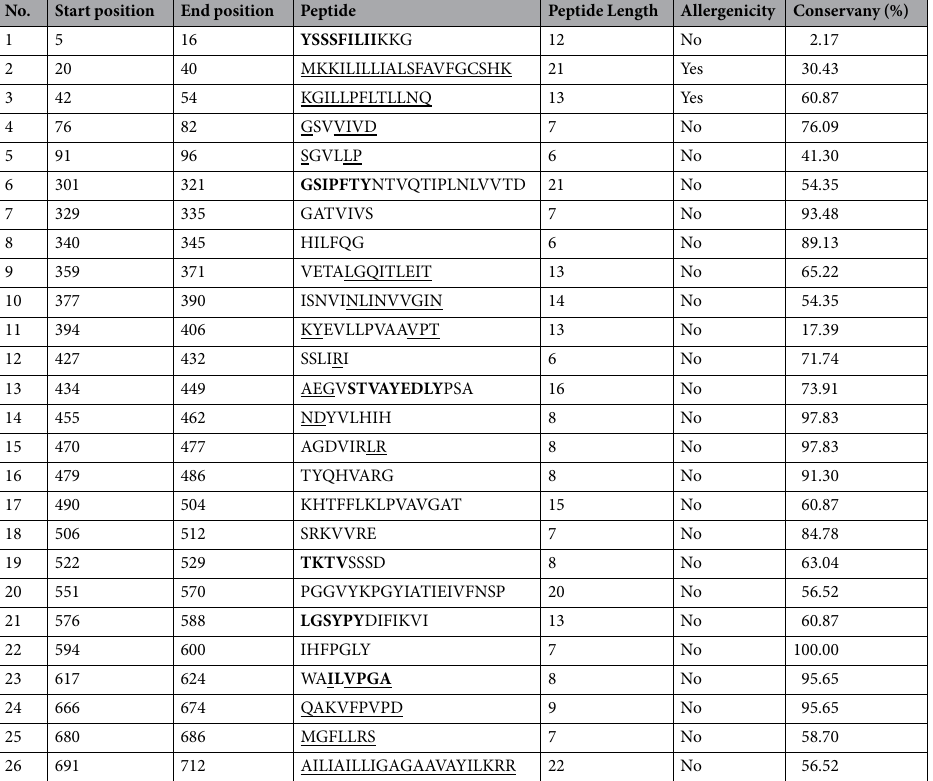
Table 4. Antigenic linear B-cell epitopes of lipoprotein Q75FL0 with their conservancy and allergenicity. 26 antigenic sites were predicted. Residues underlined and in bold were also predicted as conformational B-cell and CTL epitopes